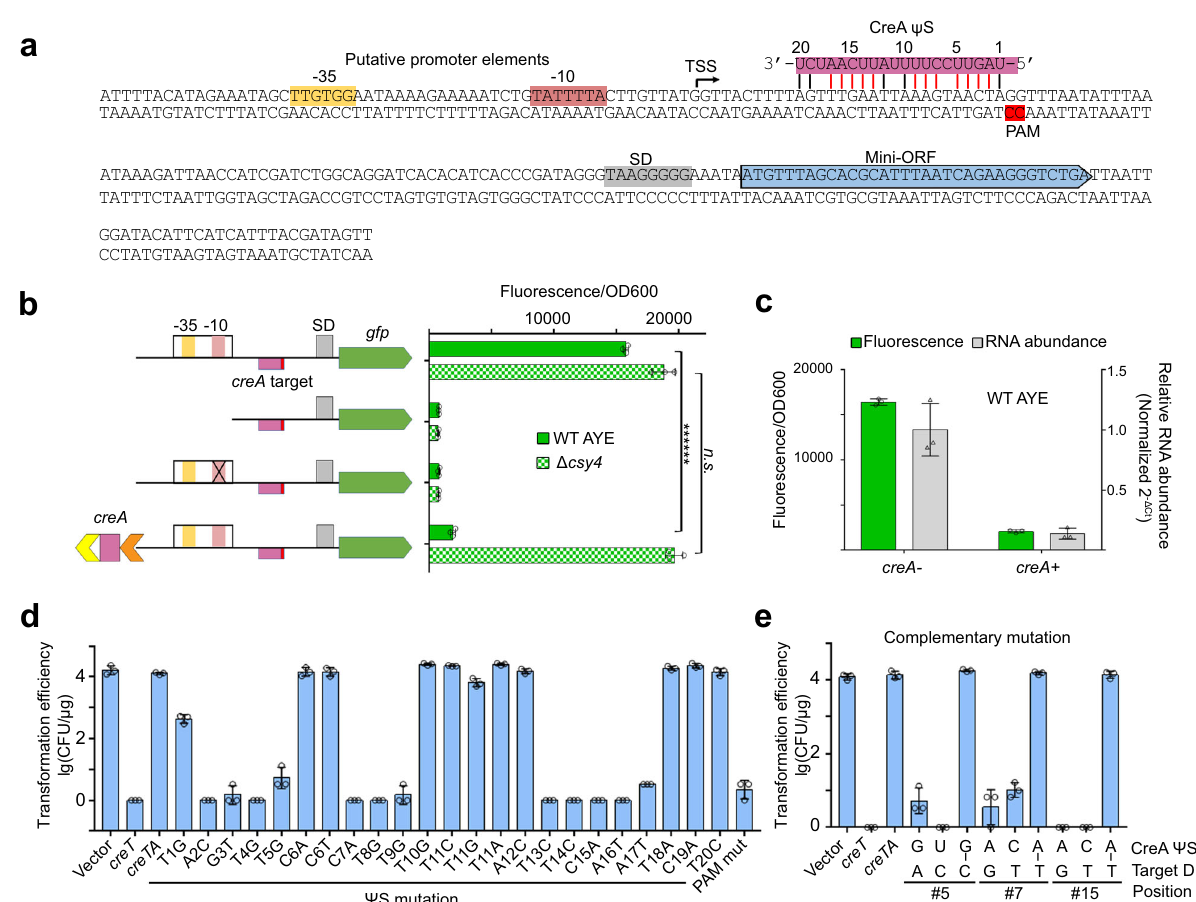
Fig. 3 | WCHA45 CreA transcriptionally represses its cognate creT . a The target site of CreA. Base pairingsbetween CreA and its target are indicated by “ | ” with the red ones proved to be critical for its antitoxin function (see d ). b Validation of the predicted promoter elements of creT and its repression by CreA using the gfp reporter gene. Note that the Ψ R2-replaced CreA was employed for this and fol- lowing assays. Data are presented as mean value±s.d. ( n =3 biological replicates). Two-tailed Student ’ s t test [ n.s ., not signi fi cant ( P >0.05); ****** P <0.000001. P =1.46894E − 07, 0.274299515 (top to bottom)]. c Assess the repressing effects of